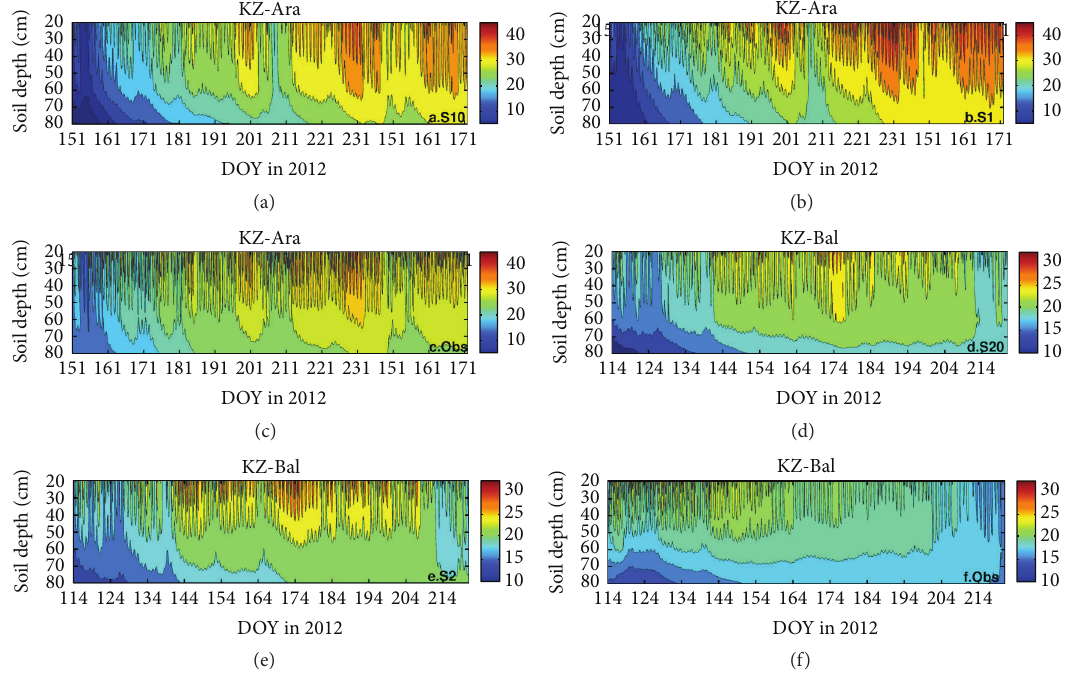
Figure 5: Panels (a) and (b) are the isograms changed with time and depth variation for the reference model (S0) and the model with refined roughness length (S1), and (c) shows the corresponding observed data at the depth of 20–80 cm below ground at the KZ-Ara site; panels (d) and (e) are the isograms for S0 and S1 and (f) shows the observations at the KZ-Bal